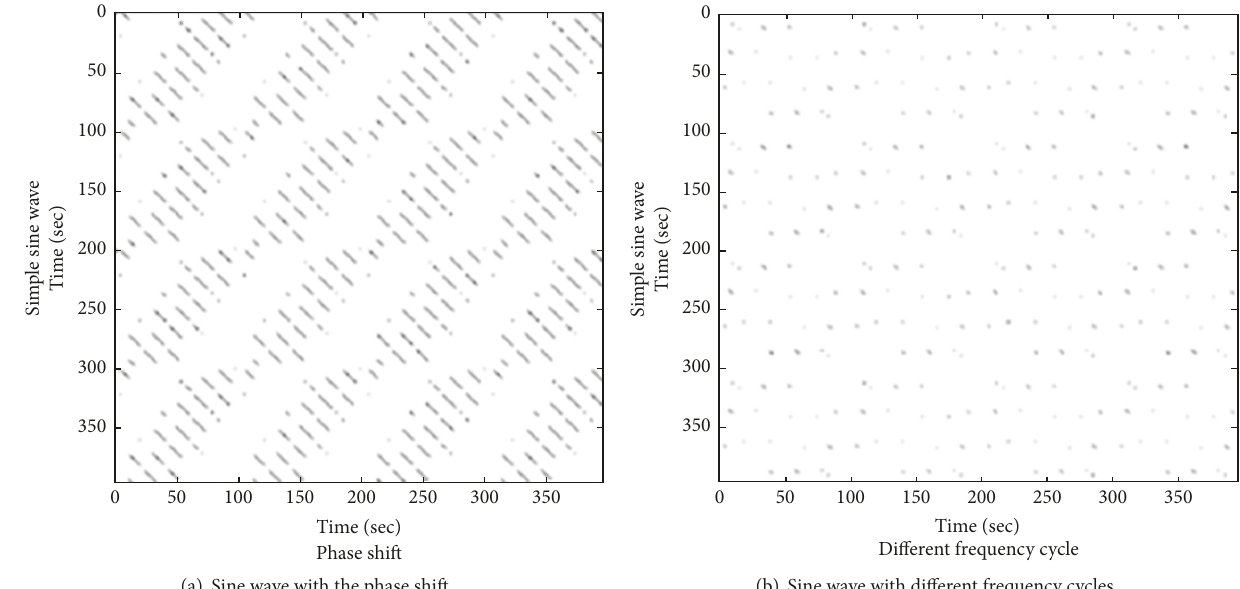
Figure 3: CRP for sine